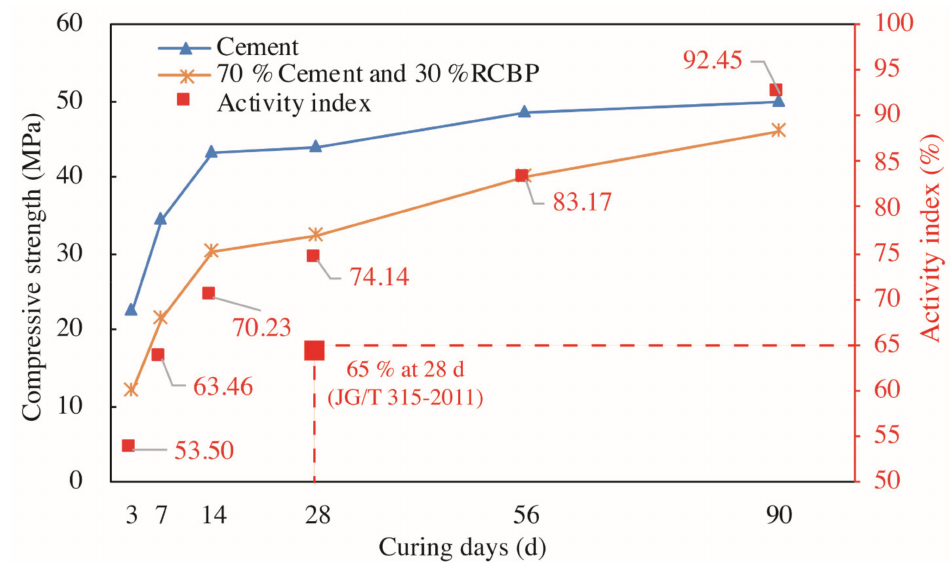
Figure 7. Compressive strength and strength activity index of reference (without RCBP) and experi- mental mortar (with RCBP).